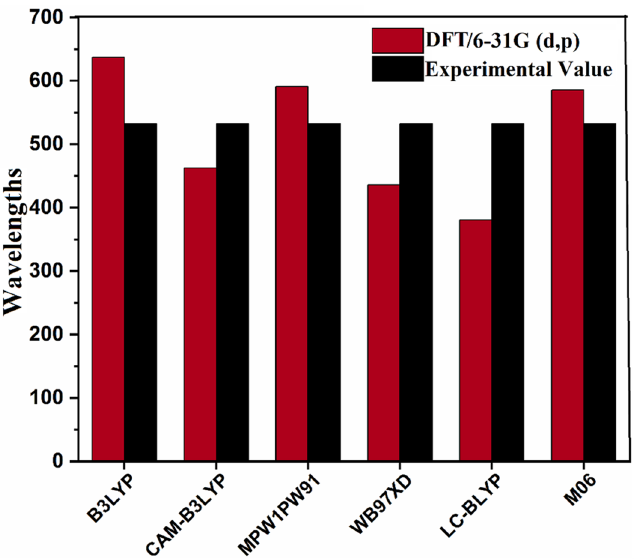
Figure 2. Graphical representation of comparison between experimentally and DFT calculated results of BDD-IN in chloroform (CHCl 3 ) solvent at various functionals by utilizing origin 8.5 version (https:// www. origi nlab. com/). All out put files of entitled compounds were accomplished by Gaussian 09 version D.01 (https:// gauss ian. com/ g09ci